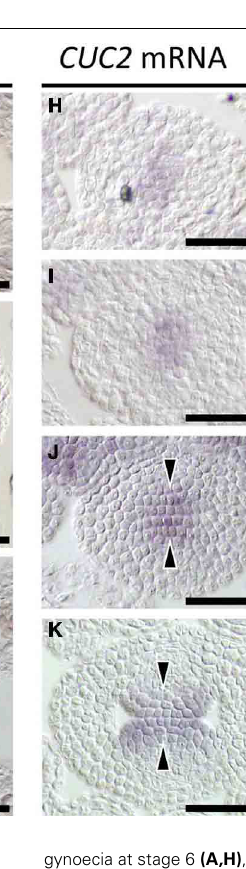
STM (A–F) and FIL (G,H) . Sections are prepared from gynoecia at stage 8 (A,D,G,H) , early stage 9 (B,E) and mid stage 9 (C,F) . Scale bars are 50 µ